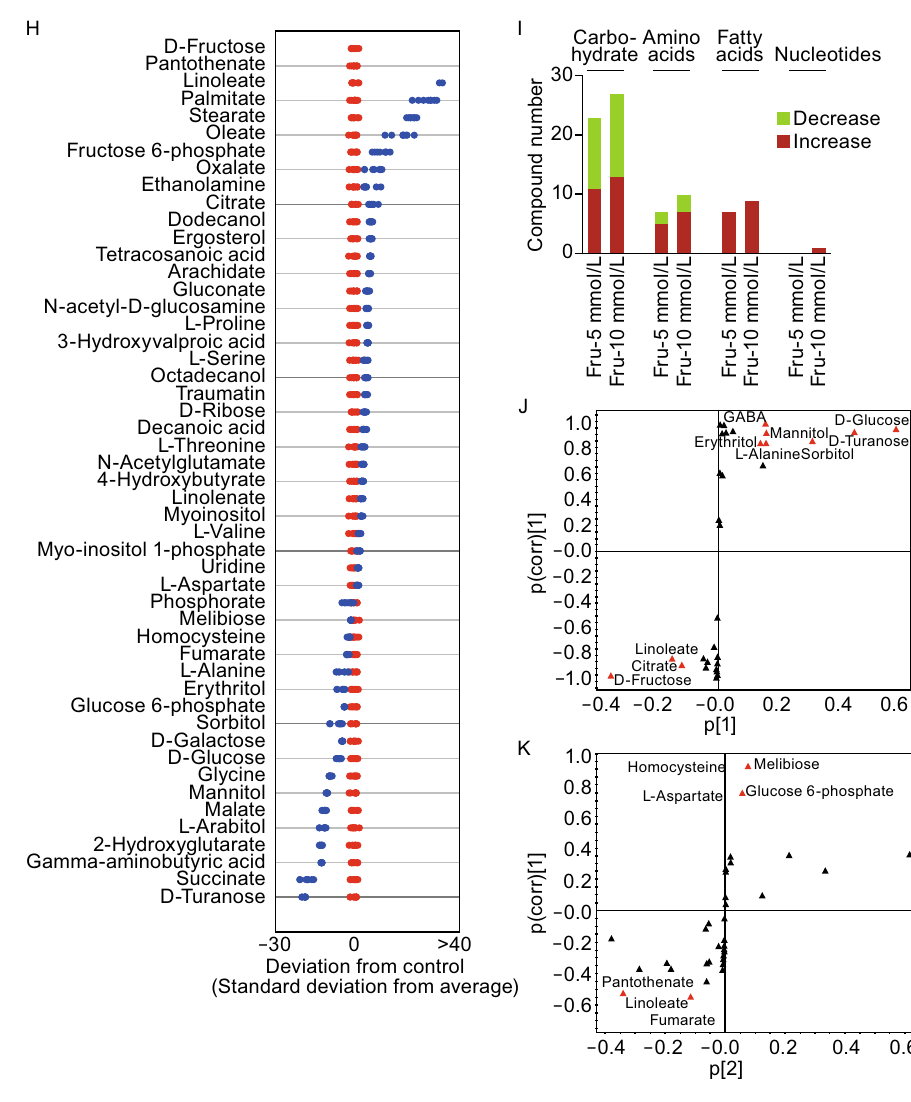
metabolic pro fi le of P. citrinum W1. In these experiments, the Pearson correlation coef fi cient between two technical repli- cates varied between 0.994 and 0.999 (Fig. S1A), ensuring the con fi dence of the dataset for further analysis. A total of 166 aligned individual peaks were obtained from each fun- gus sample after the removal of internal standards and the known peaks for solvent. From these, we identi fi ed 62 metabolites, and the abundance of these metabolites in P. citrinum W1 grown in 5 mmol/L and 10 mmol/L fructose, as well as in the negative control, are shown in Fig. S1B. By supervised orthogonal partial least squares discriminant analysis (OPLS-DA), the two test groups and control group (without fructose) are clearly separated; with component t[1] separating the groups with fructose from the control (Fig. 1E). No signi fi cant outliers were found in the PCA scores plot of all the samples, suggesting that the samples